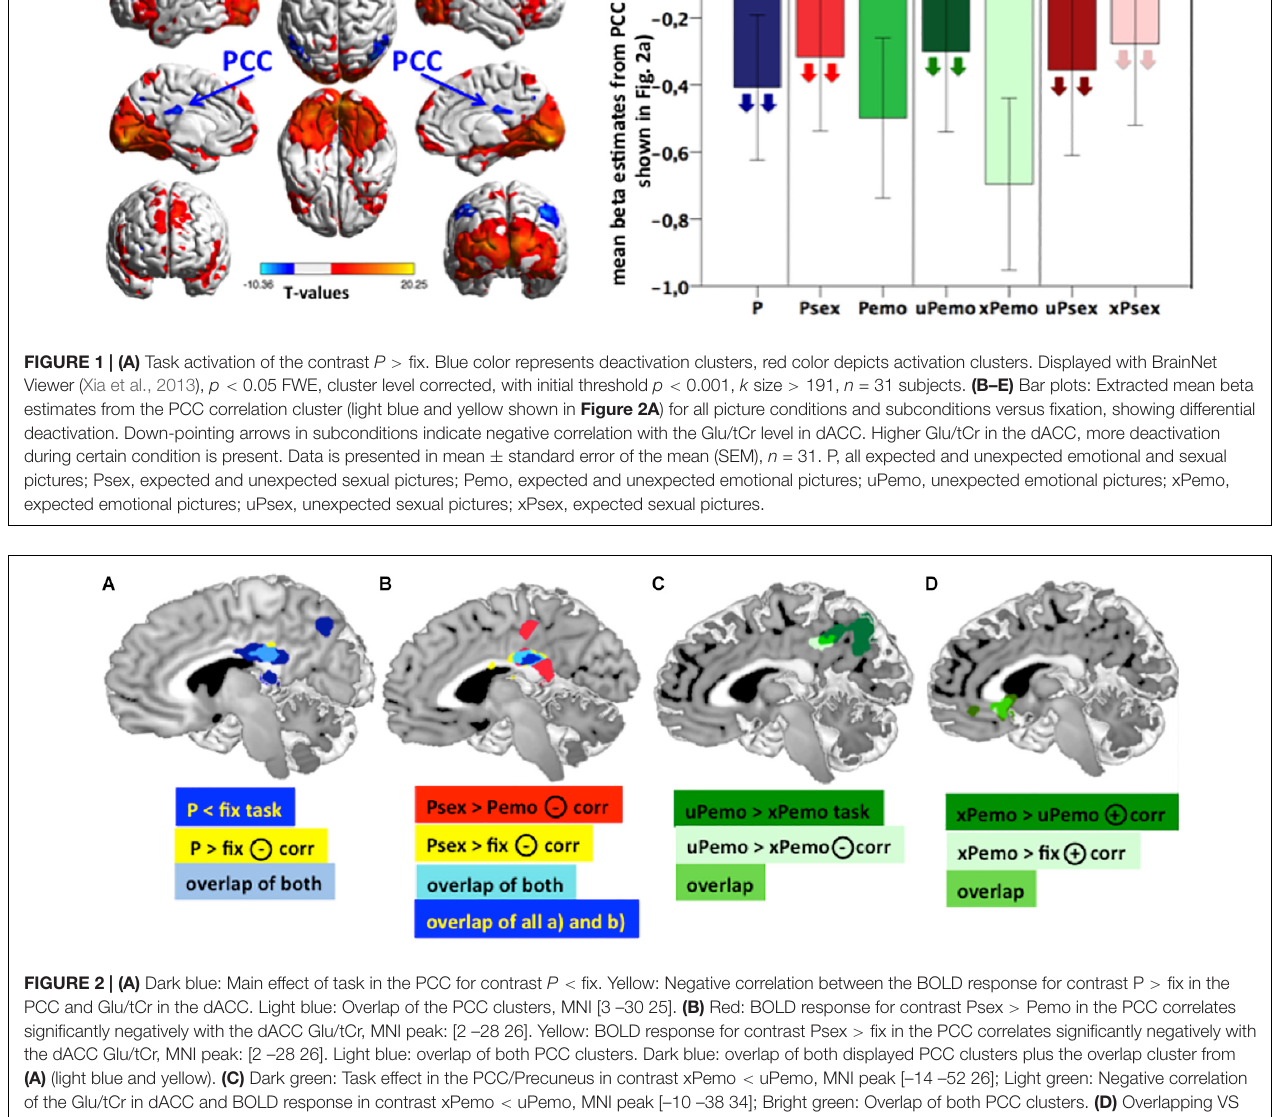
correlation of deactivations to both individual conditions in the PCC (xPsex > fix: p < 0.05 FWE, cluster level corrected, k = 3398 and uPsex > fix: p < 0.05 FWE, cluster level corrected, k = 128; Supplementary Table S2